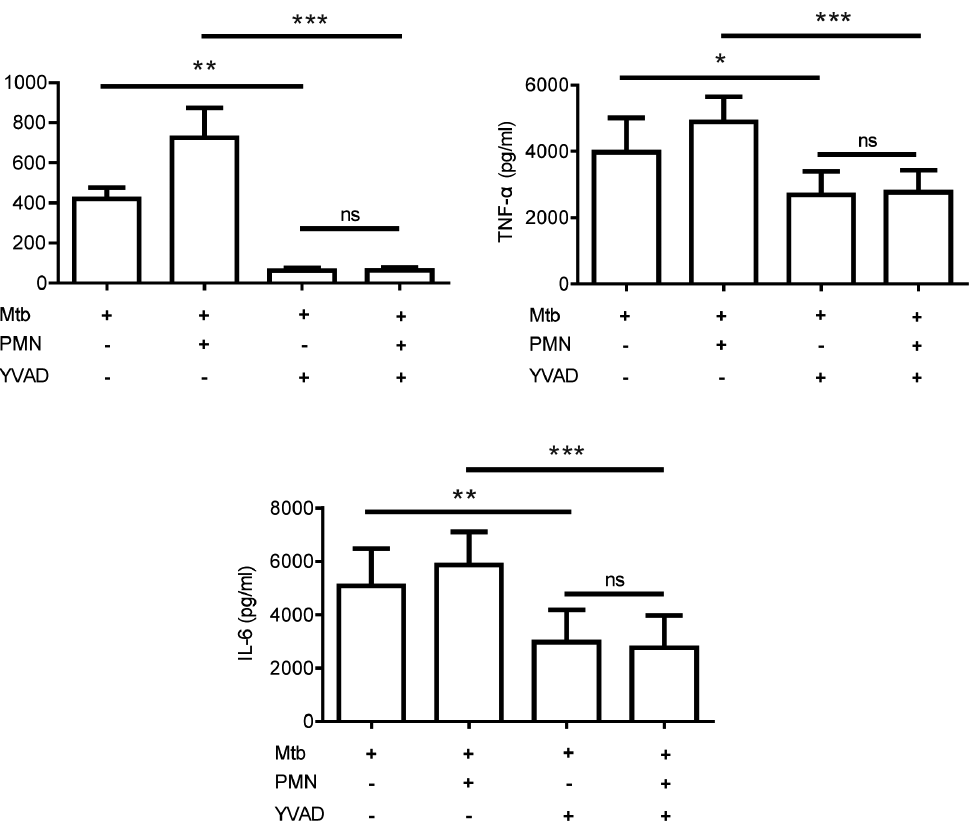
Figure 7. Apoptotic neutrophils augmentation of cytokine release depends on caspase-1 activity. hMDMs, with or without pre- incubation with Ac-YVAD-CMK (caspase-1 inhibitor), were stimulated with c -irr Mtb with or without PMNapo at a ratio of 2:1 for one hour where after non-ingested prey were removed and the hMDMs were cultured for 18 h. Cytokine levels were measured by cytometric bead array, and data are expressed as mean cytokine released + SEM (n=6). Differences between groups are shown as * (p , 0.05), ** (p , 0.01) or *** (p , 0.001).